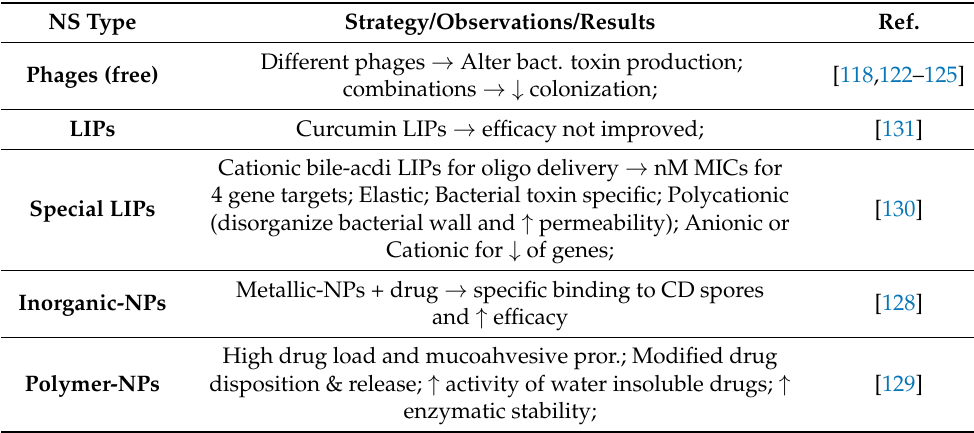
Table 4. Nanosystems for treatment of CDI